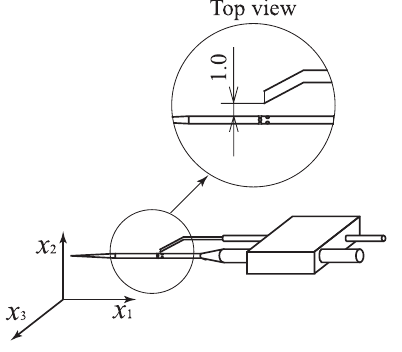
Fig. 9 Combined sensor of I-type hot-wire and pressure